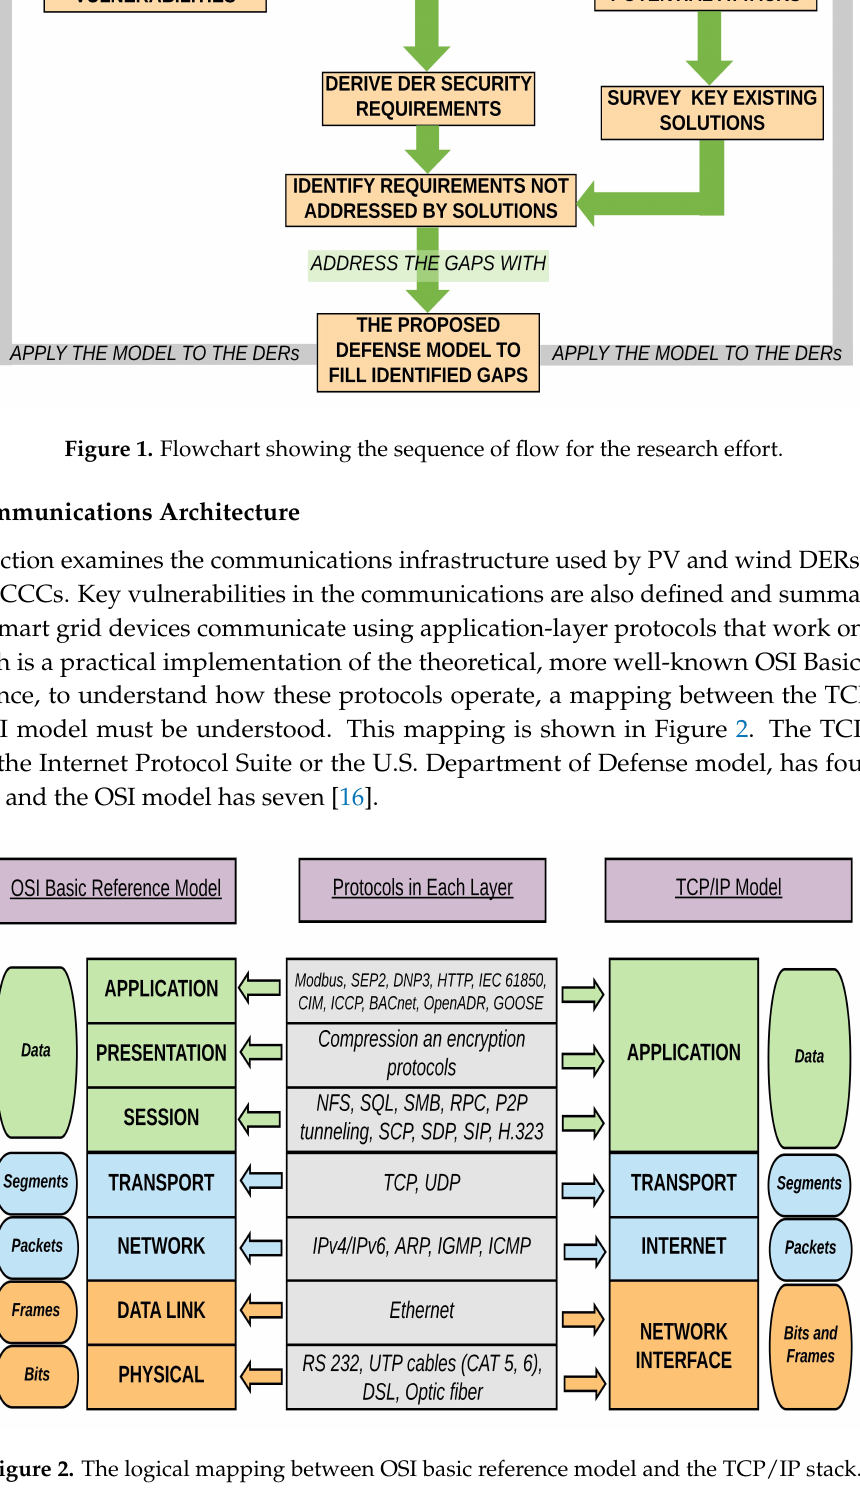
Figure 2. The logical mapping between OSI basic reference model and the TCP/IP